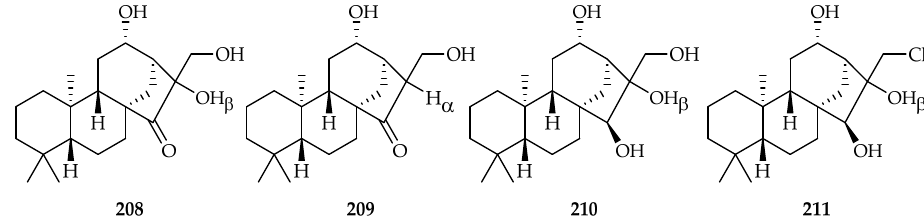
Figure 83. Structures of mesonols A-C 208–211 [130].